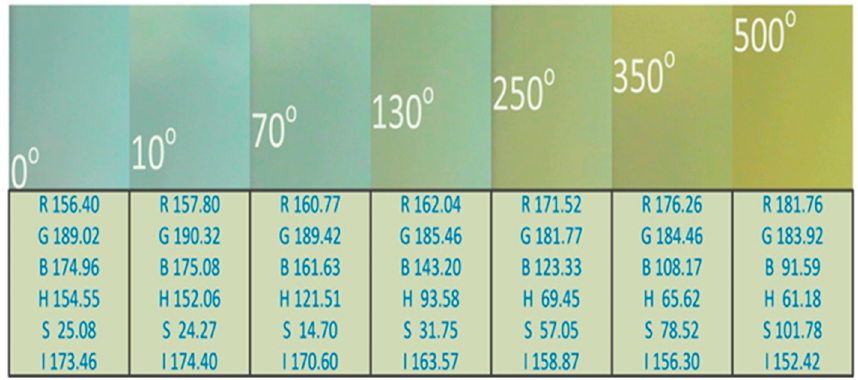
Figure 6. Partial image data and the corresponding color components.